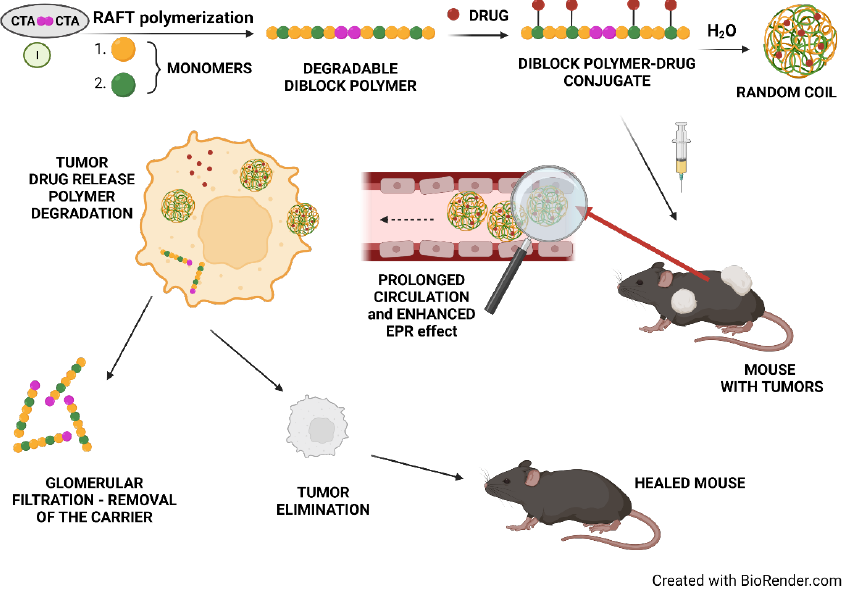
Figure 10. Overall principle of the diblock polymer synthesis and its application in tumor therapy.